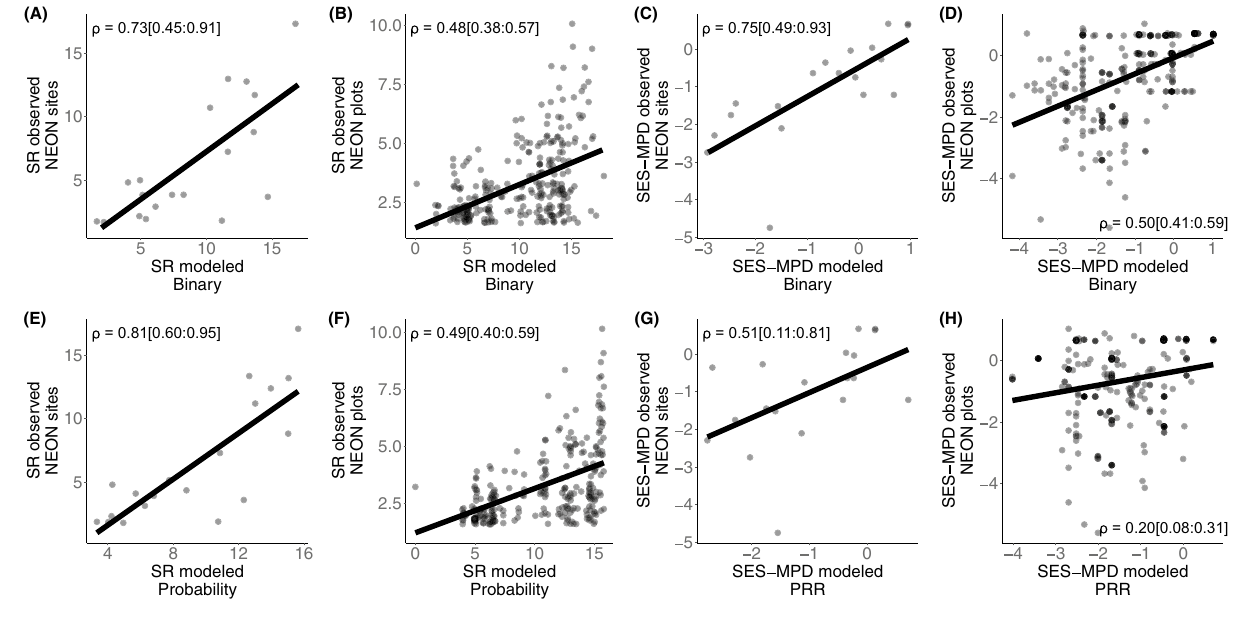
Figure 3. Predicted versus observed number of co-occurring oak species (left panels) and phylogenetic assemblage structure (right panels) at site and plot scales. Rho (ρ) values within each panel represent the median Pearson’s correlation coefficients estimated from posterior distribution and the 95% of credible intervals within brackets.